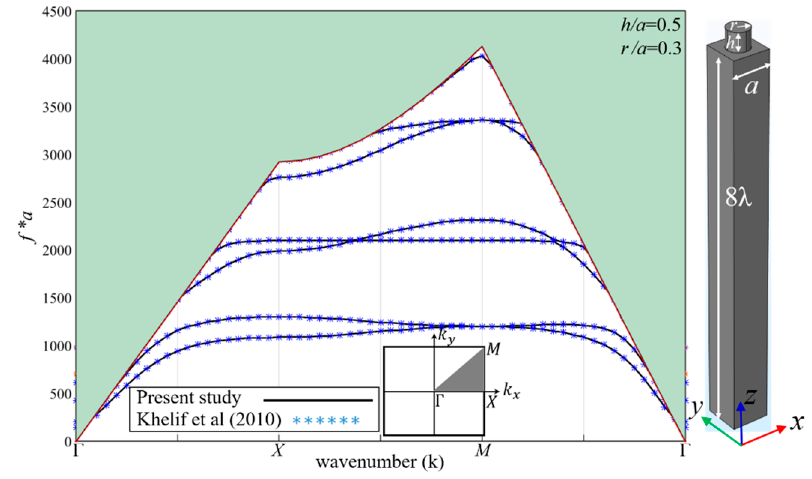
Figure 2. Model validation.